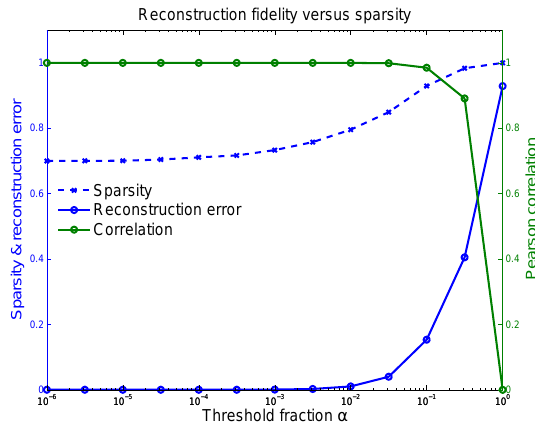
Figure 4. Variation of sparsity, reconstruction error (cid:15) and the Pearson correlation between the true and reconstructed f V i.e. ρ ( f V , f V 0 ) as a function of α